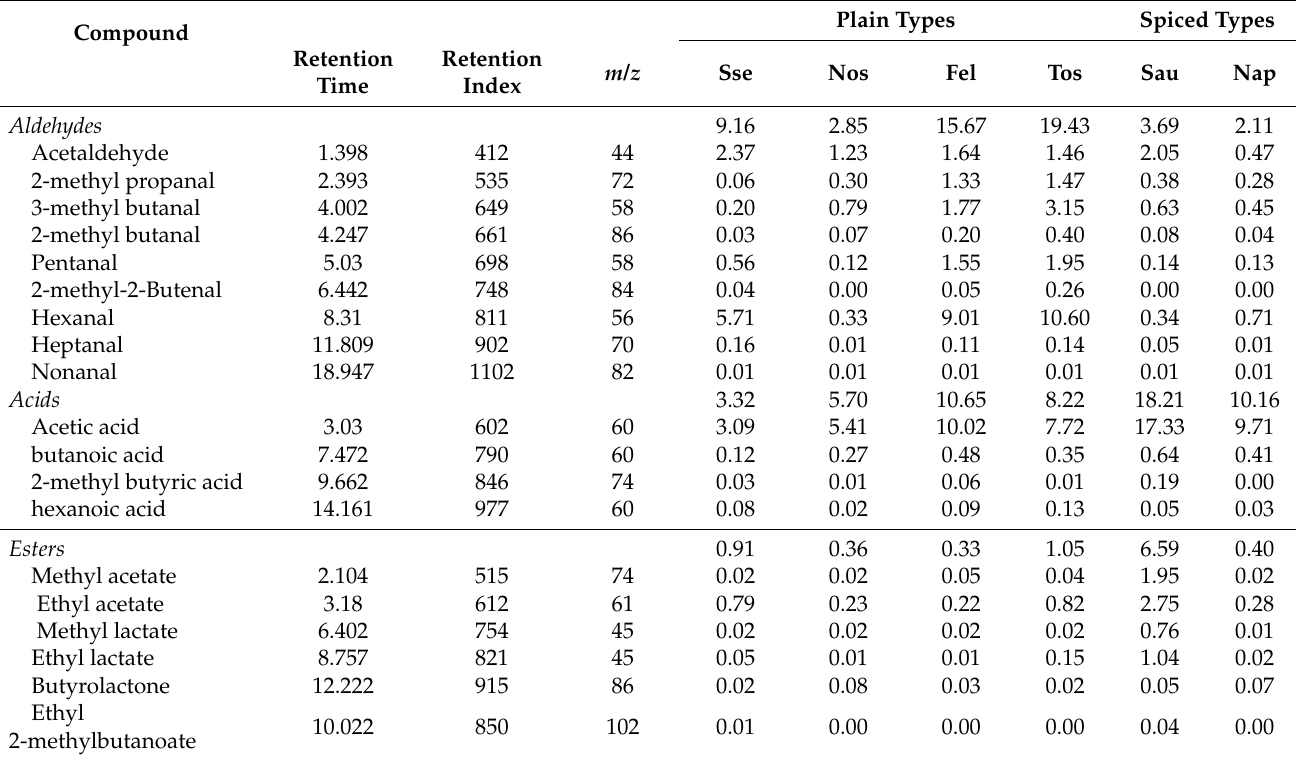
Table 5. Product aroma attributes of volatile compounds (% of area relative to the total chromatographic peak area of the identified peaks) via solid phase microextraction, gas-chromatography-mass spectrometry (SPME GC-MS) of six fermented meat products ( n =